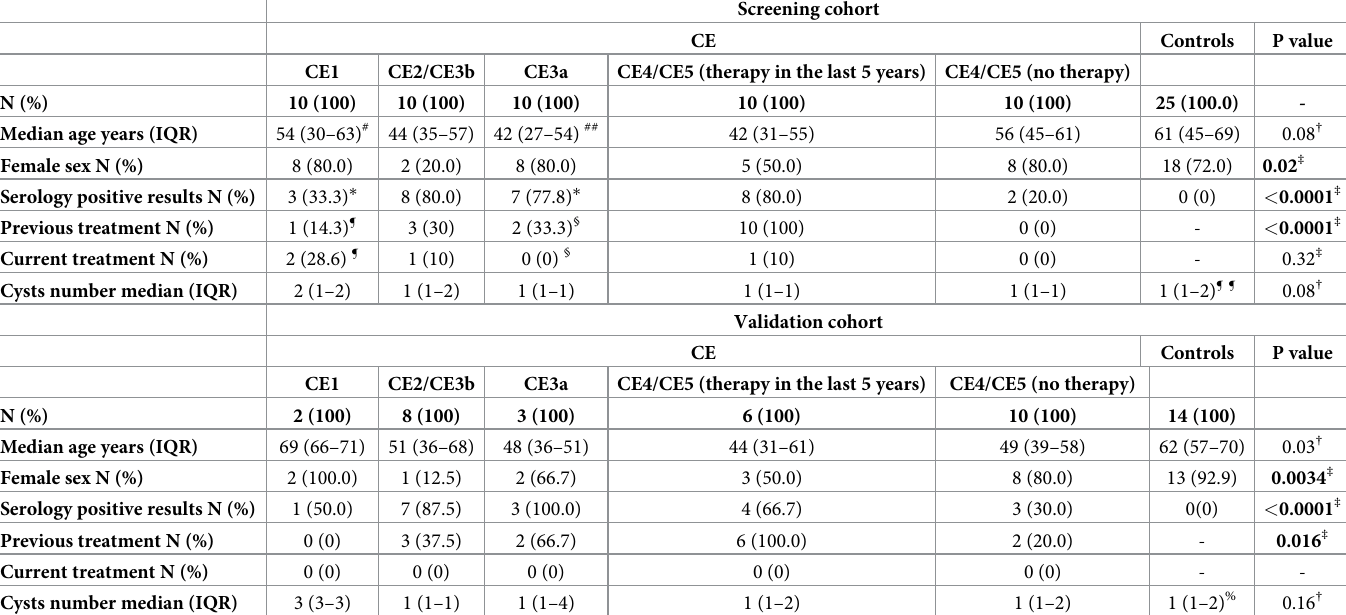
Table 1. Demographical and clinical characteristics of the screening and validation